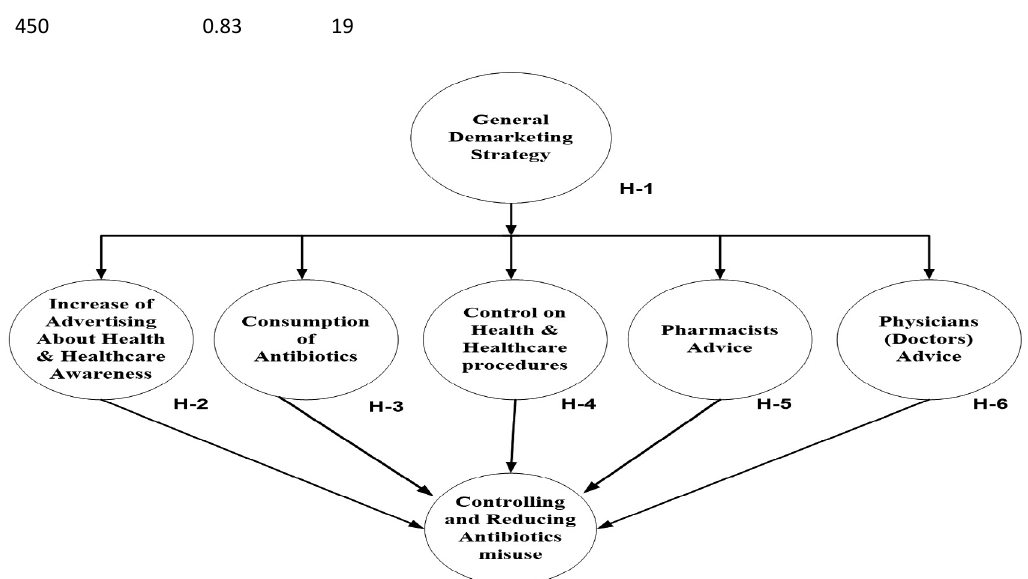
Fig. 1. Study model, shows the dimensions and the relation between